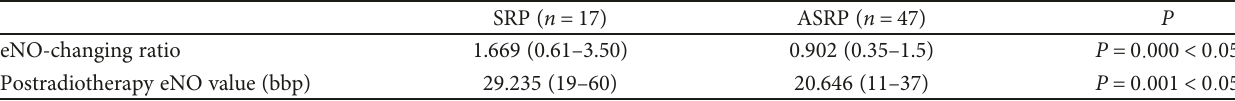
Table 1: Comparison of eNO-changing ratio and postradiotherapy eNO value between the two groups. SRP ( n = 17 ) ASRP ( n = 47 ) P eNO-changing ratio 1.669 (0.61 – 3.50) Postradiotherapy eNO value (bbp)